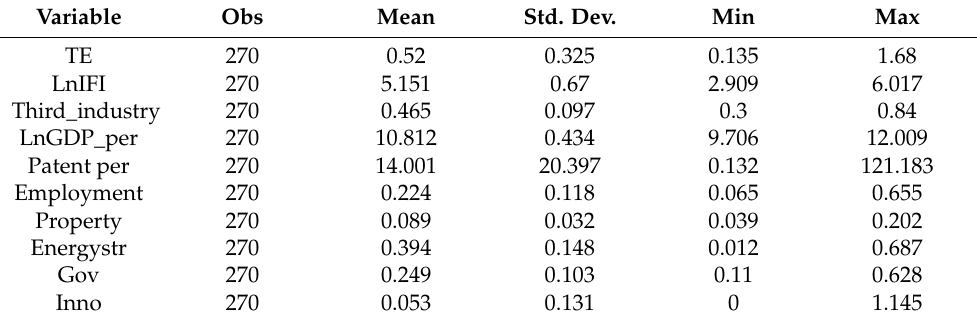
Table 3. Descriptive statistics.